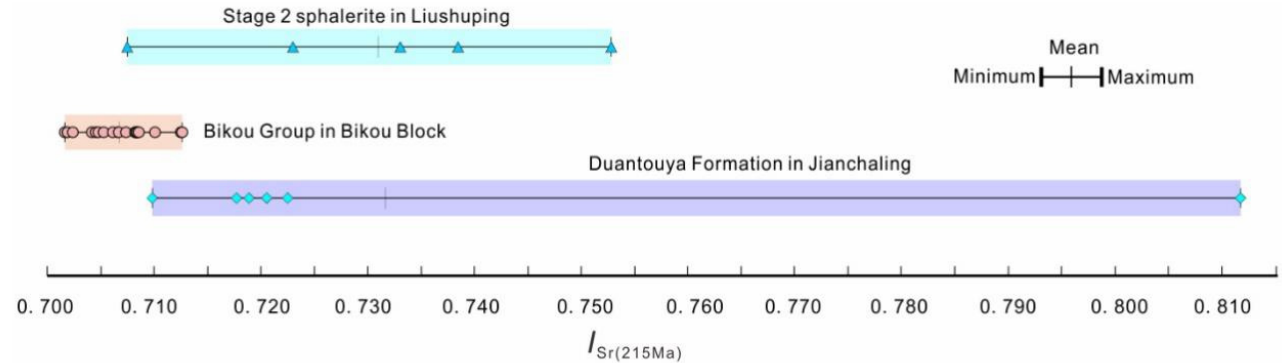
Figure 9. Isotope systematics for the Liushuping deposit showing I Sr (t) plot. t = 215 Ma